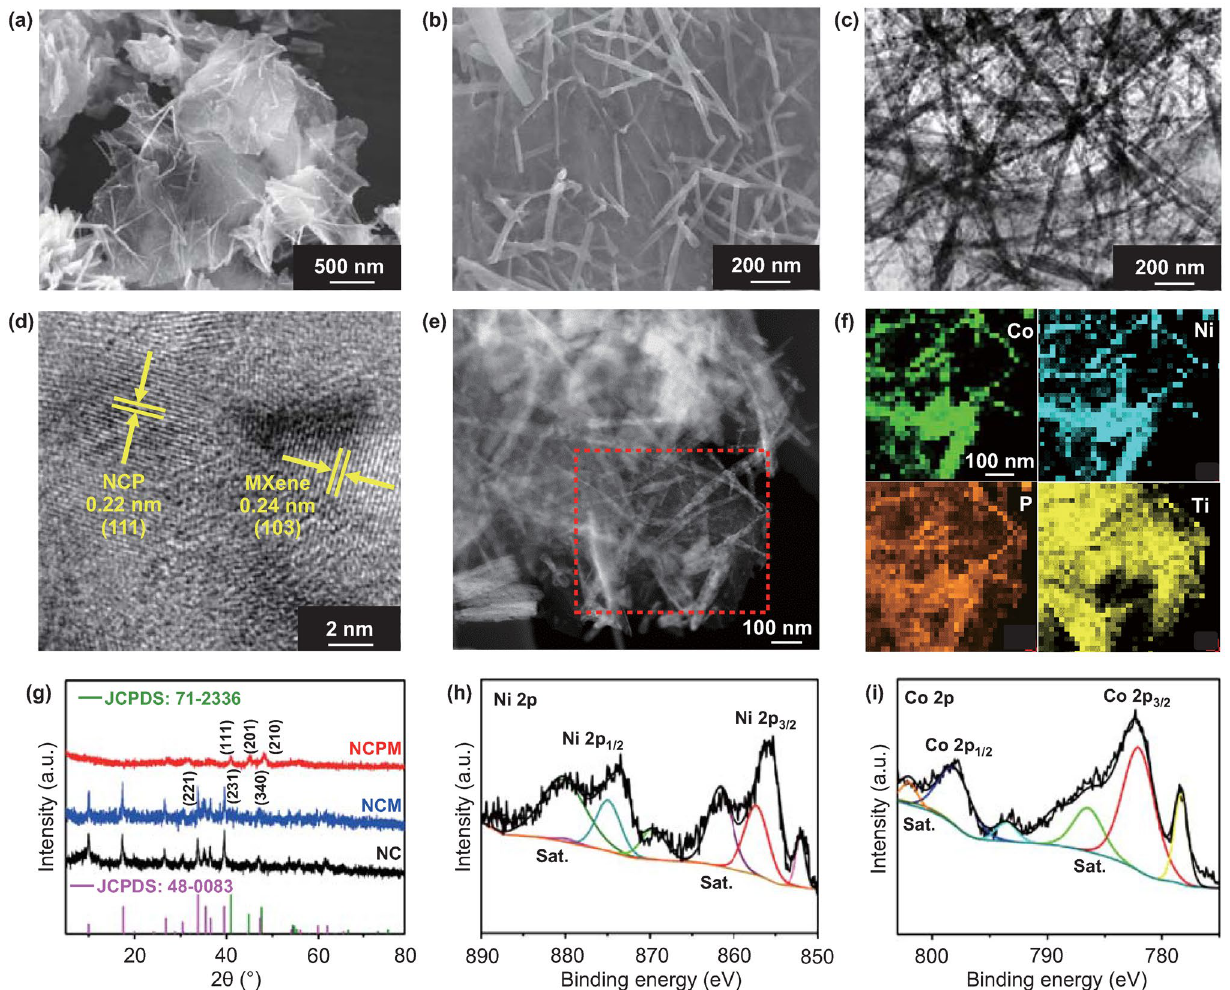
Fig. 2 a , b SEM images of NCPM composites. c Low-magnification TEM and d HRTEM images of NCPM corroborating the tight assembly of MXene and NiCoP. e STEM image and f elemental maps of NCPM. g XRD patterns of NC, NCM, and NCPM. h Ni 2p and i Co 2p XPS spectra of